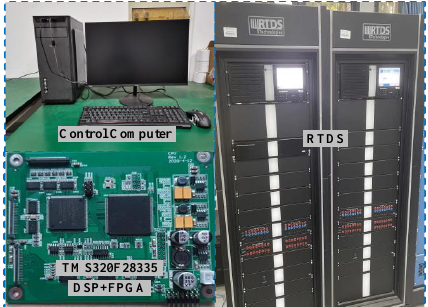
Figure 15. Experimental platform of the GCI.